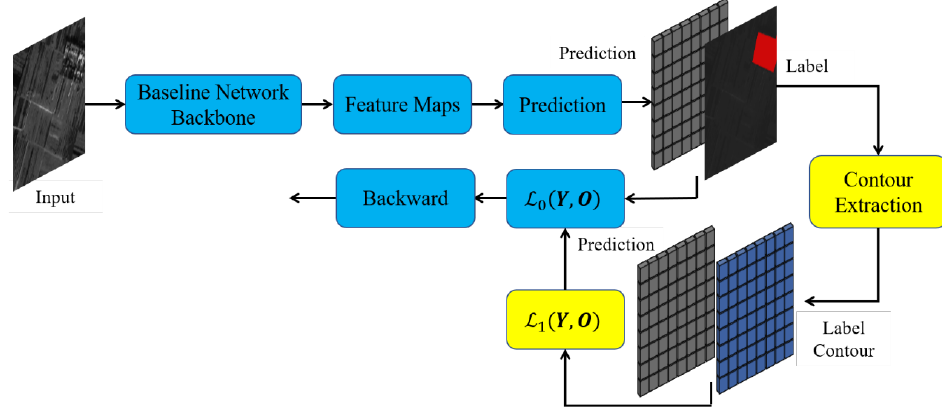
Figure 6. Regularized extraction model structure of residential area (ours).